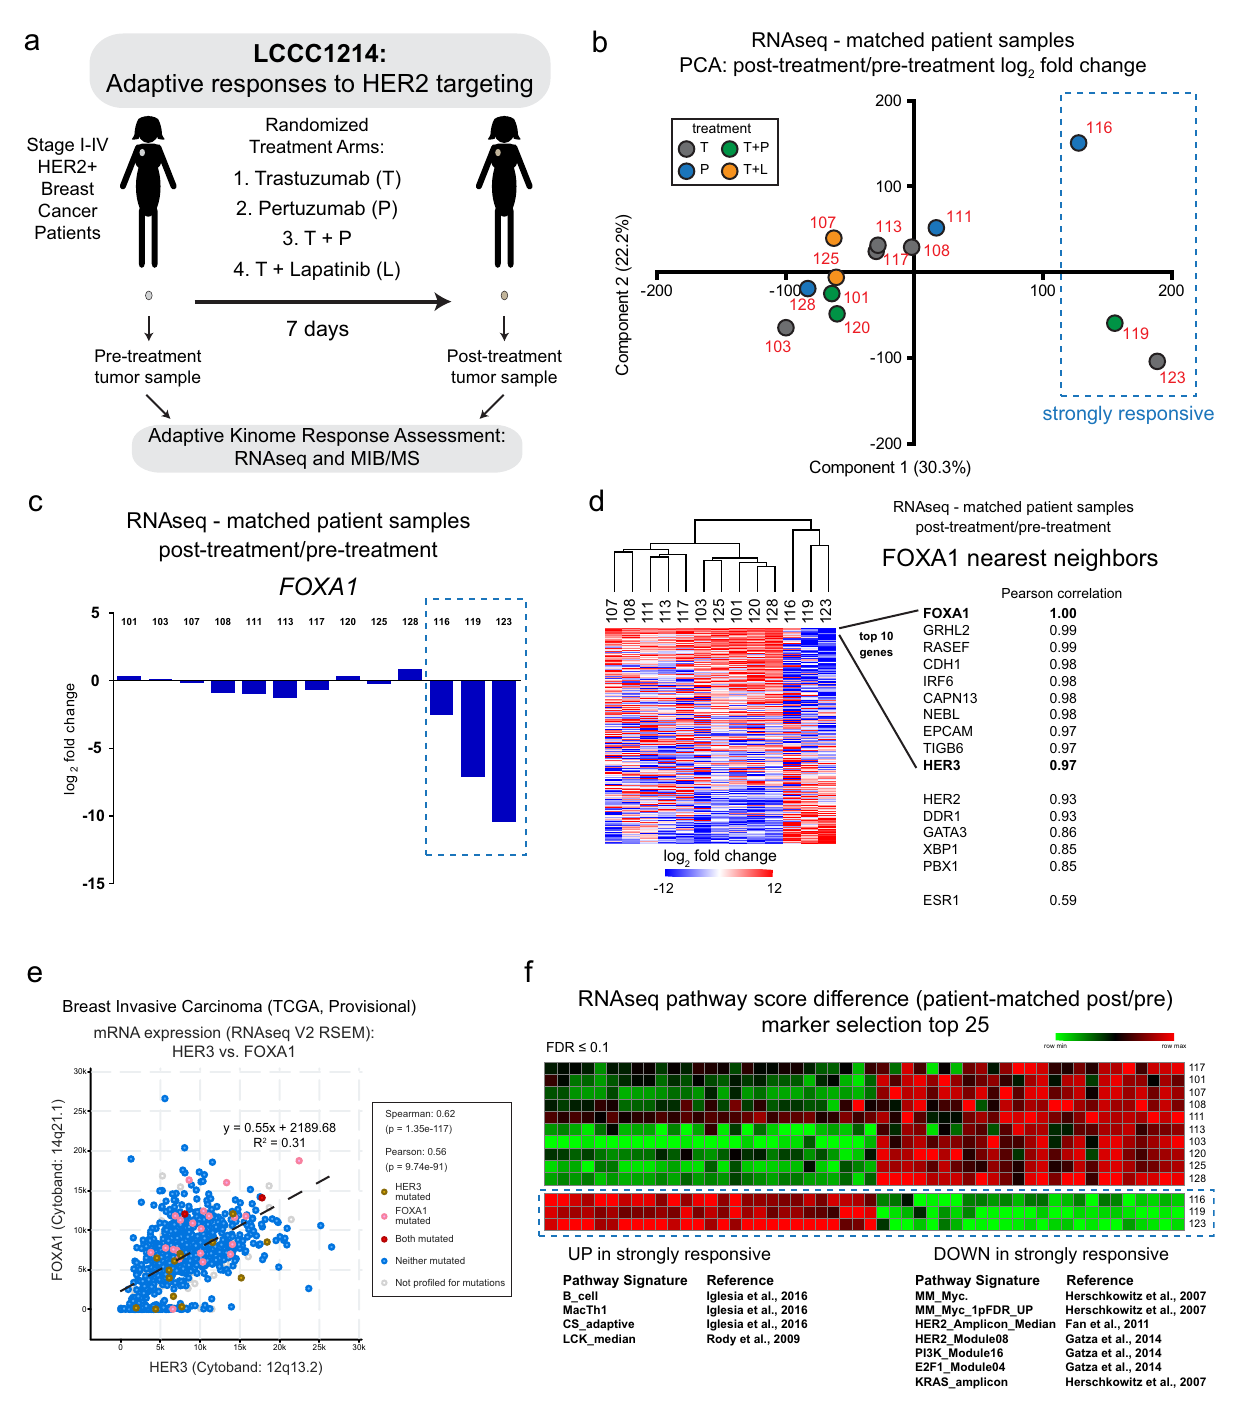
similar across antibody-based anti-HER2 treatments. The log 2 fold change in expression for matched patient samples was used for principal component analysis of the transcriptome (Fig. 4b). Three matched pairs (from patients 116, 119, and 123) were notably distant from the other 10 patient pairs. We also observed segregation of these sample pairs by unsupervised hierarchical clustering of the expressed kinome (Supplementary Fig. 4b). The three distinct sample pairs repre- sented three different treatment arms (patient 116, P; 119, T + P, 123, T) so a speci fi c treatment did not dictate their